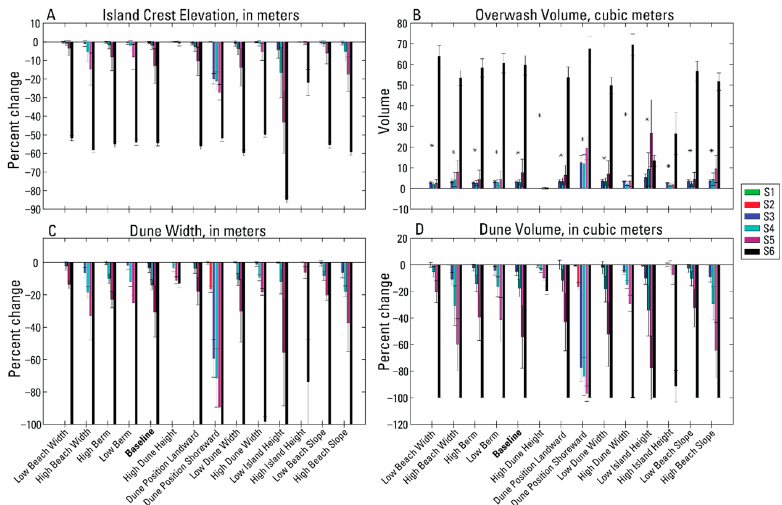
Figure 8. 1D post-storm percent change to the maximum island crest elevation ( A ), dune width ( C ), and dune volume ( D ) for storms 1 through 6 (S1–S6). 1D post-storm calculated overwash volume ( B ); note that asterisks indicate the pre-storm dune volume. Metrics are provided in the panel titles to indicate those features that were analyzed, not the values presented in the graphs. Note: y -axis scales differ among panels.